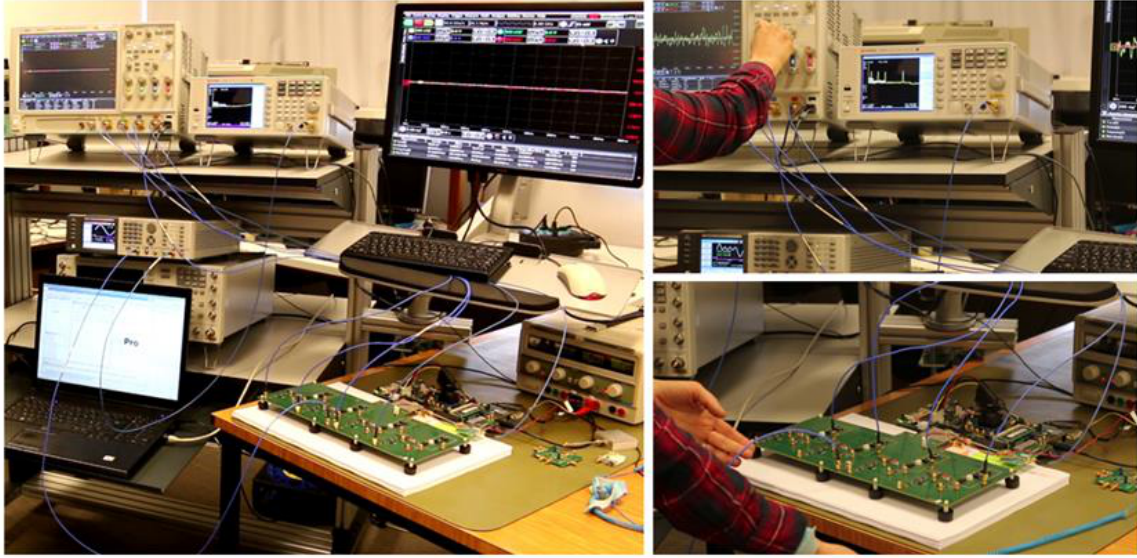
Figure 6. Experimental testbed for the evaluation of data reduction invariant LASSO algorithm.